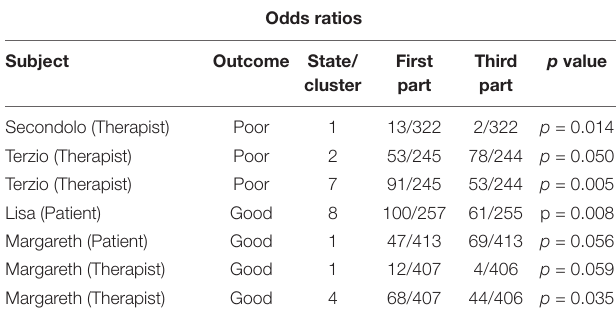
TABLE 6 | Results of odds ratios between the first and third part of each psychotherapy.